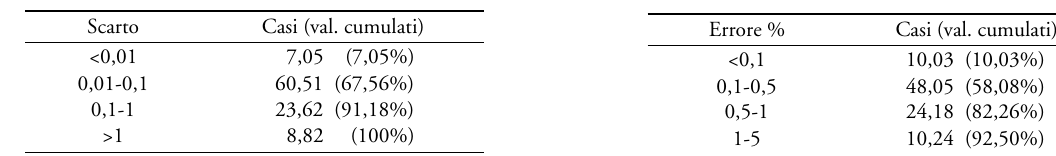
Errore percentuale nella stima del punto